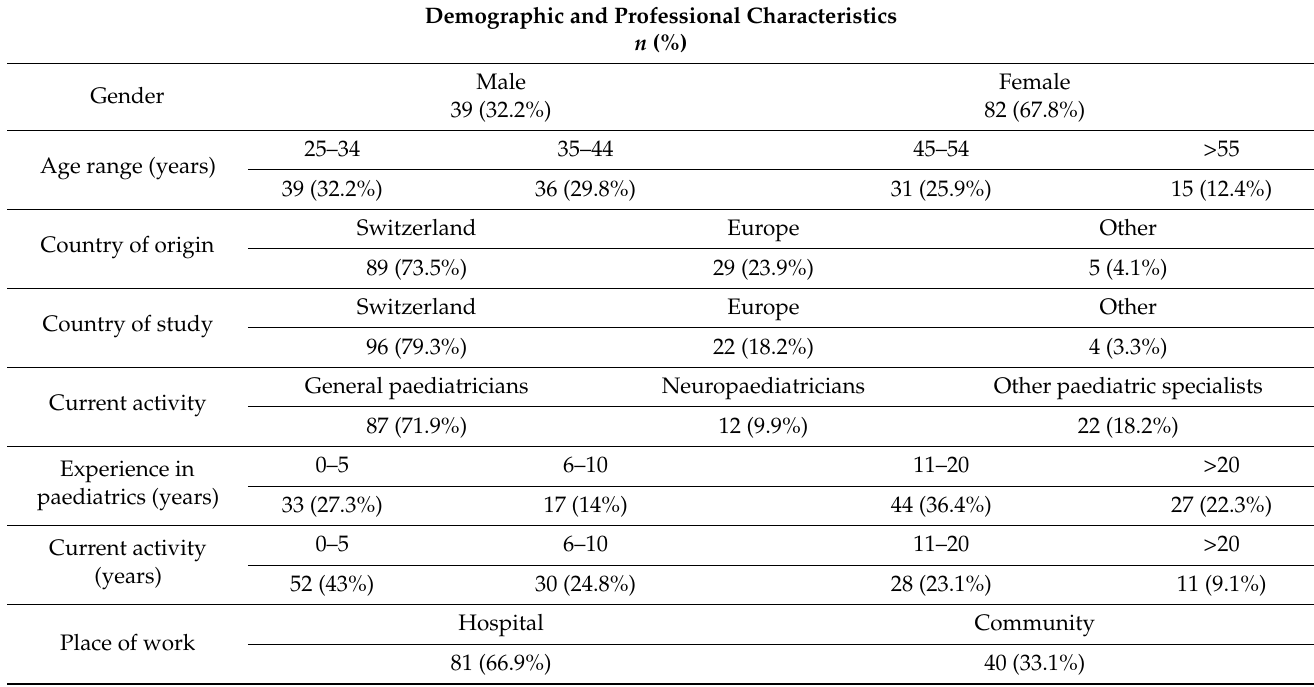
Table 1. Personal characteristics of survey respondents.